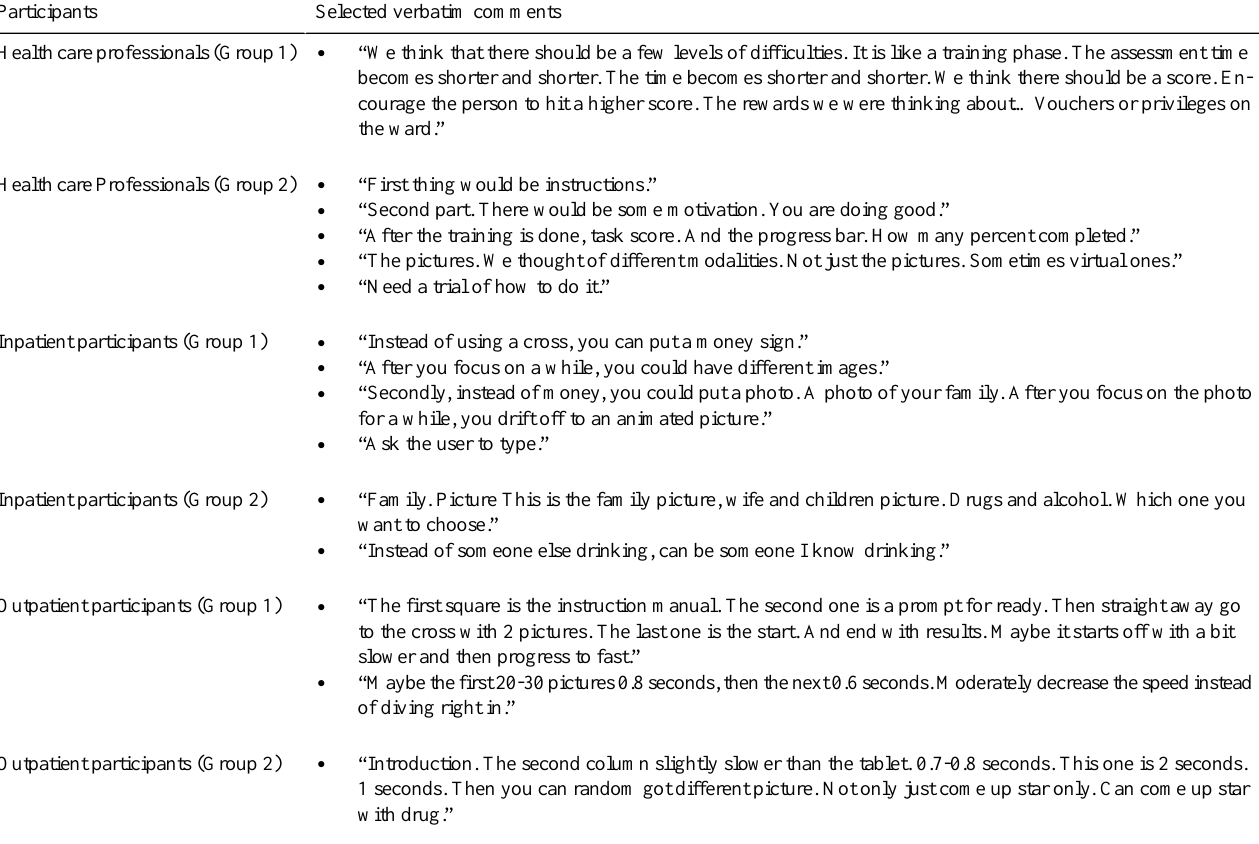
Table 5. Participants’comments on their newly conceptualized prototypes (one participant was asked to share on behalf of the whole group). Selected verbatim